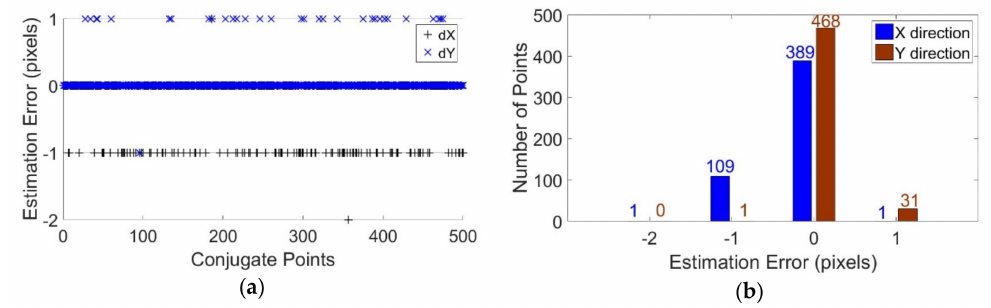
Figure 7. Image matching results at the third pyramid level of the HRSC Level-3 images.